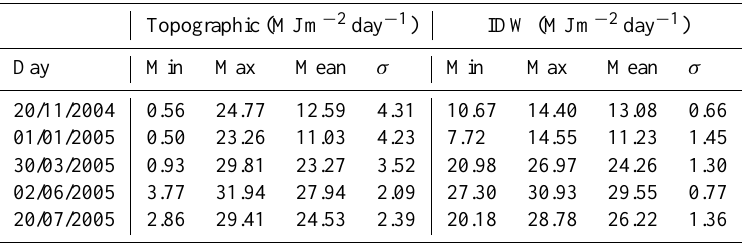
Table 3. Maximum, minimum, mean and standard deviation (MJm − 2 day − 1 ) of daily solar radiation estimates in the watershed on selected days obtained by the topographic approximation and IDW to the values measured at stations with daily available datasets (601, 602, 603, 702 and 802).